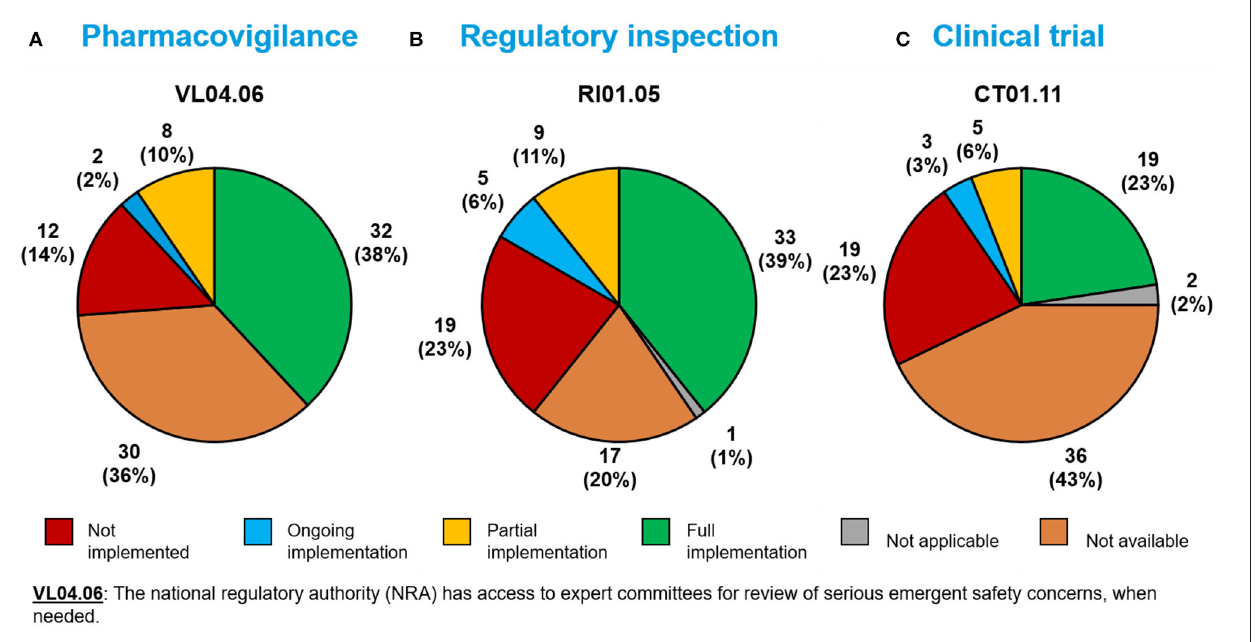
FIGURE 4 | Implementation of WHO Global Benchmarking Tool sub-indicators related to (A) pharmacovigilance, (B) regulatory inspection, and (C) clinical trials during a public health emergency, among 84 Member States benchmarked from 2016–2020.